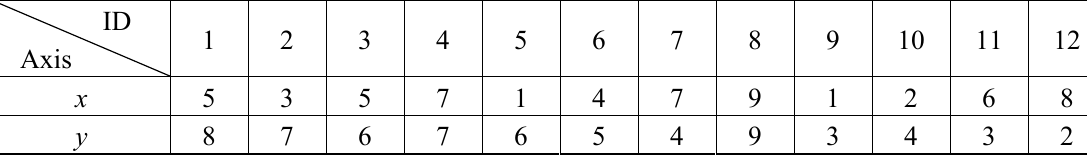
Table 2. Coordinates for nodes in the example.